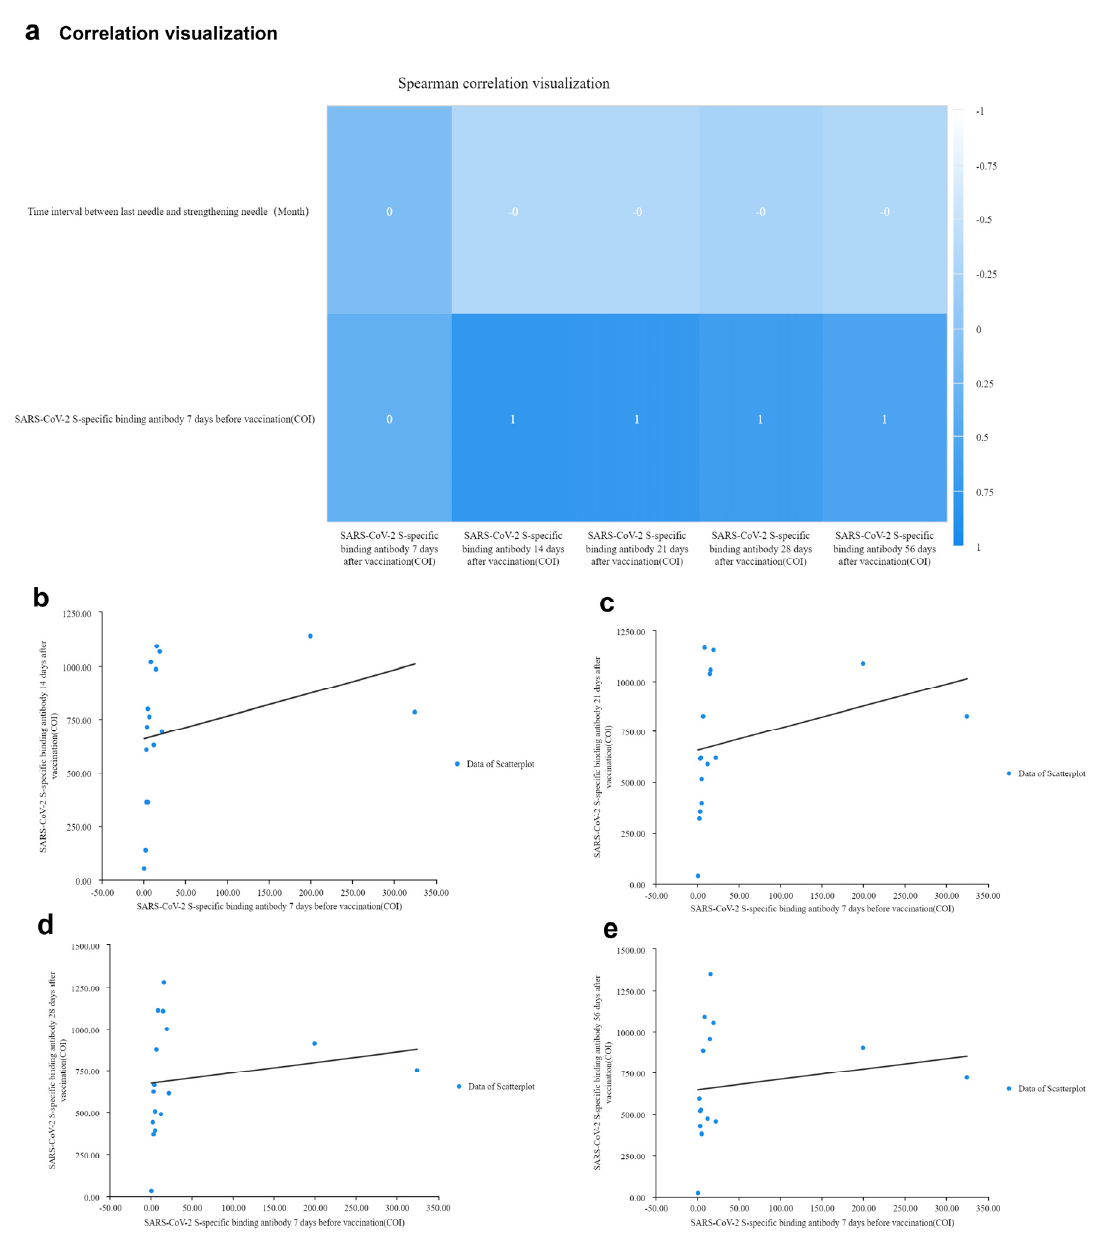
Figure 5. Correlation analysis of SARS-CoV-2 S-specific binding antibodies concentration. ( a ) Correla- tion analysis between SARS-CoV-2 S-specific binding antibody concentration and booster vaccination interval; correlation analysis between SARS-CoV-2 S-specific binding antibody concentration and initial antibody concentration. The higher the correlation between the two quantities, the closer the p -value is to 1, the darker the blue. ( b – e ) Trend graph of the correlation between initial antibody concentration and antibody concentration at 14 days, 21 days, 28 days, and 56 days after